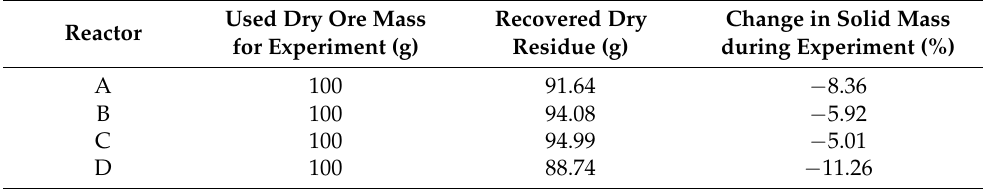
Table 4. Masses of dry feed ores and recovered residues from the pyrite oxidation experiment and percent change in solid mass during the experiment. Used Dry Ore Mass Reactor for Experiment (g)